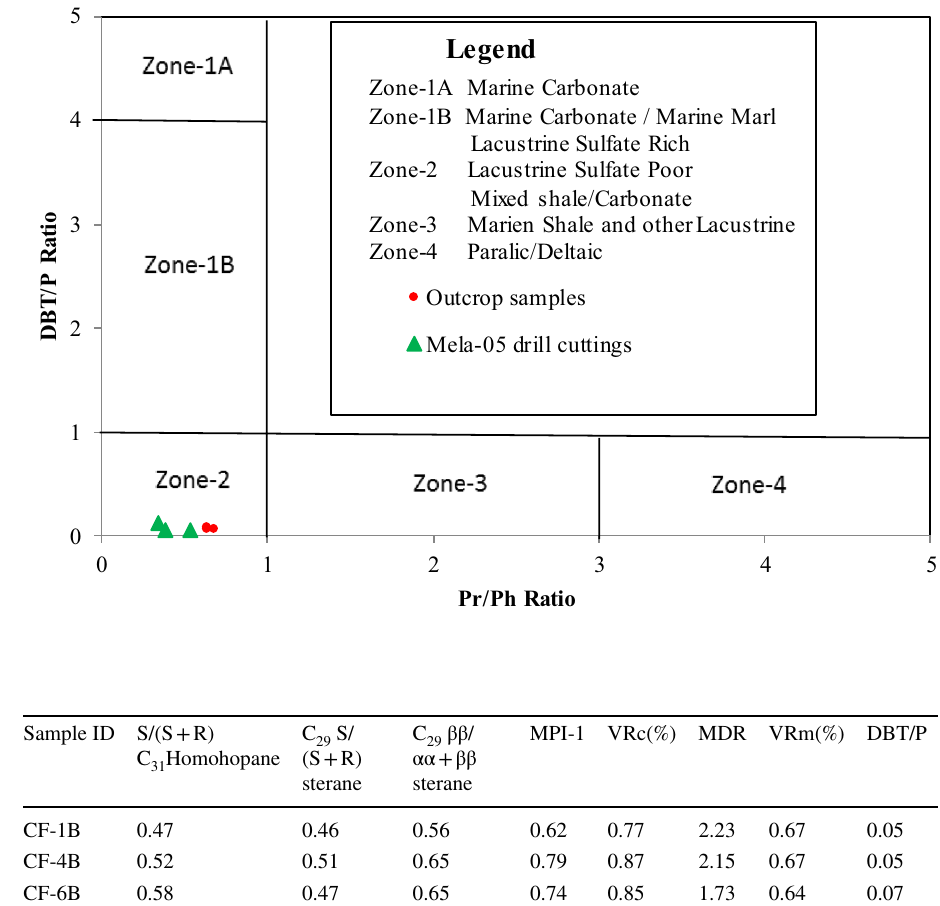
Fig. 12 The Pr/Ph versus DBT/P cross-plot of the drill cuttings and outcrop samples of the Chichali Formation (after Hughes et al. 1995)